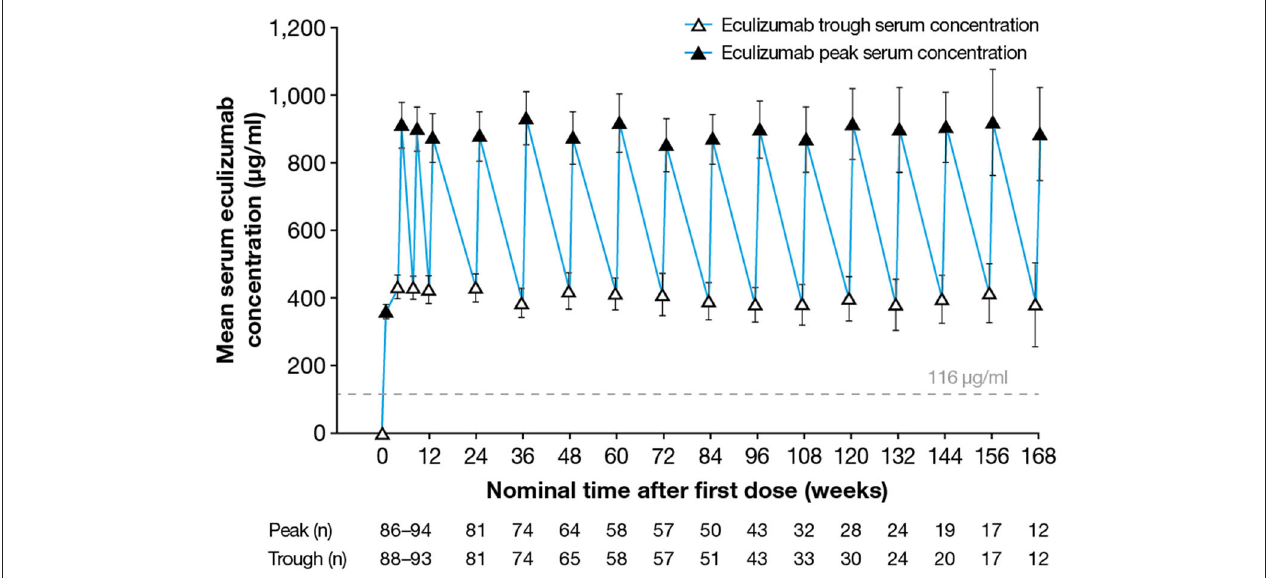
FIGURE 1 | Serum eculizumab concentrations during the study. Mean (95% confidence interval) trough and peak serum eculizumab concentrations in patients who received eculizumab in the PREVENT study; eculizumab concentrations below the lower limit of quantification (9.38 µ g/ml) were analyzed as 4.69 µ g/ml (half the lower limit of quantification). Eculizumab concentrations above 116 µ g/ml (dashed line) indicate sufficient concentration to achieve complete complement